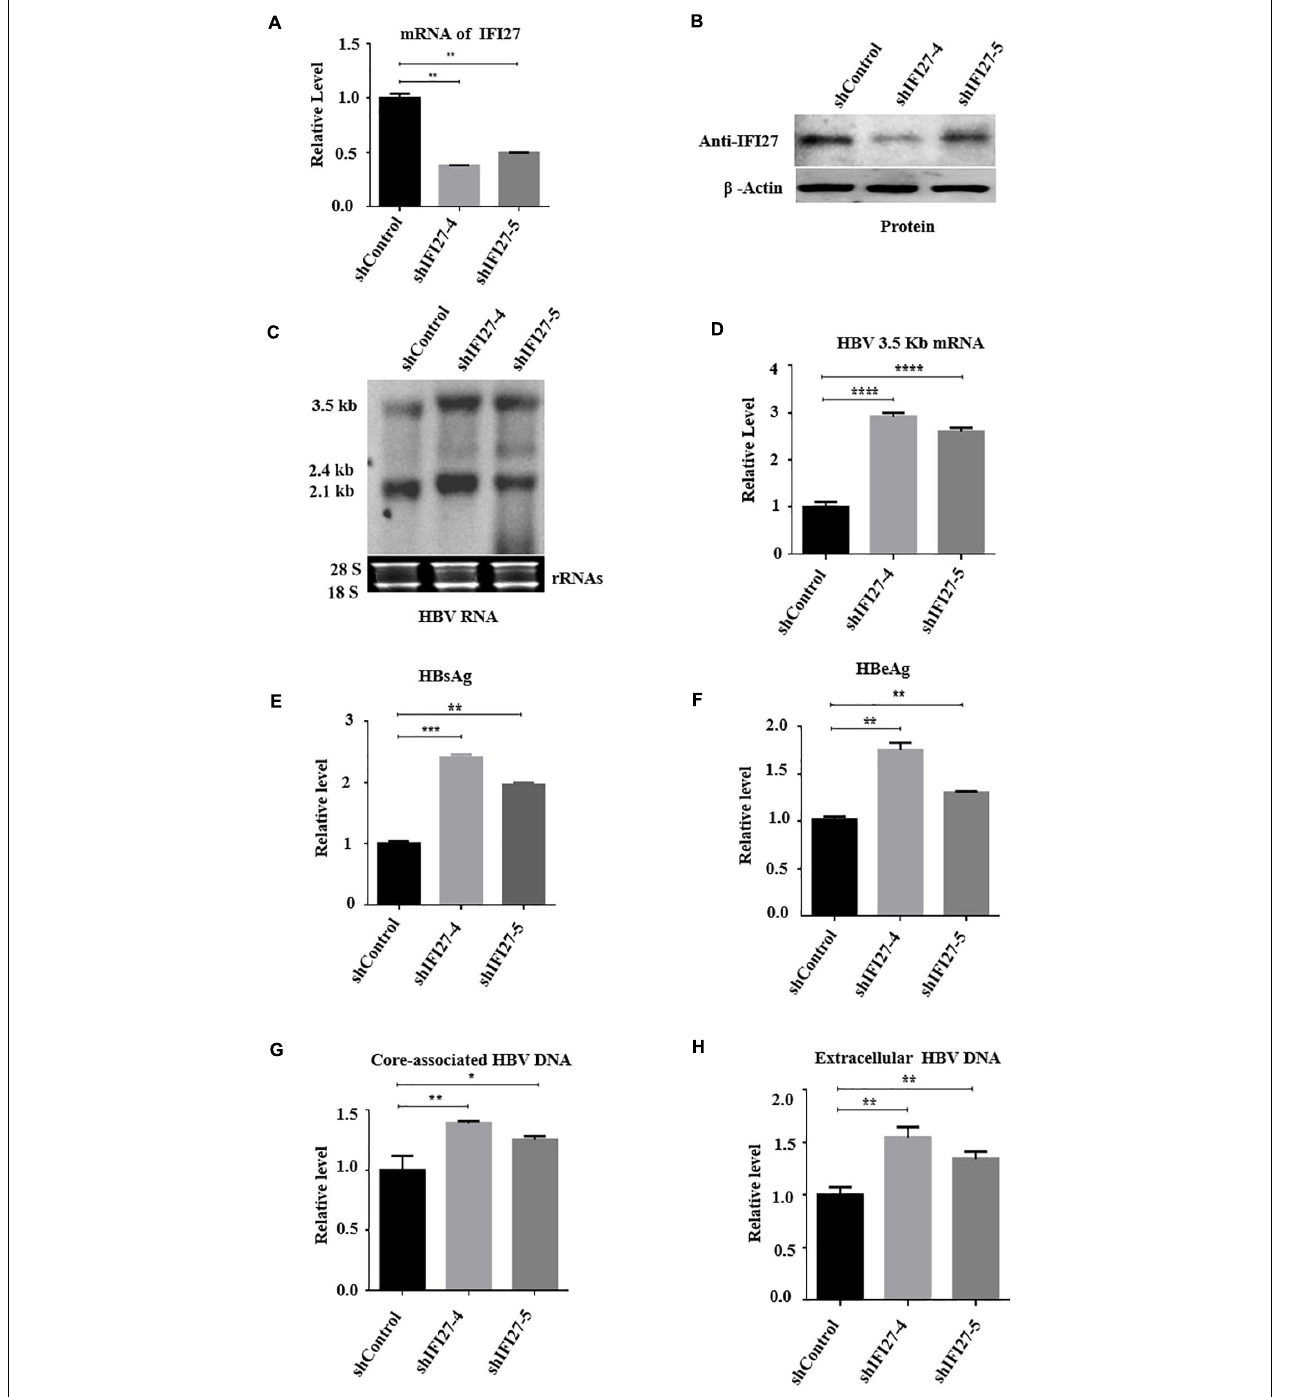
FIGURE 3 | Knockdown of IFI27 enhances HBV gene expression in HepG2 cells. (A–F) HepG2 cells in a 12-well plate were transfected with HBV1.3 (800 ng) and pSV- β -gal (200 ng), and 24 h later, the cells were transduced with lentivirus expressing IFI27-targeting shRNAs (shIFI27-4 and shIFI27-5) or scrambled control (shControl). The lentivirus-transduced cells were collected after 3 days post-transduction. (A) The levels of IFI27 mRNAs were determined by qRT-PCR. Data were normalized to GPADH mRNA expression. (B) Expression levels of IFI27 protein were analyzed by western blotting using an IFI27-specific antibody. β -Actin was used as a loading control. (C) HBV total RNA from transducing cells was extracted and HBV transcripts were analyzed by northern blot. The 28S and 18S rRNAs were used as an internal control. (D) The HBV 3.2-kb mRNA was subjected to qRT-PCR. GAPDH mRNA expression was used as a loading control. (E,F) Expression of secreted HBsAg (E) and HBeAg (F) was detected using ELISA. (G,H) The HBV intracellular core-associated (G) and extracellular HBV DNA (H) from the supernatant were extracted 4 days post-transduction and subjected to qPCR. * P ≤ 0.05, ** P ≤ 0.01, *** P ≤ 0.001, **** P ≤ 0.0001.